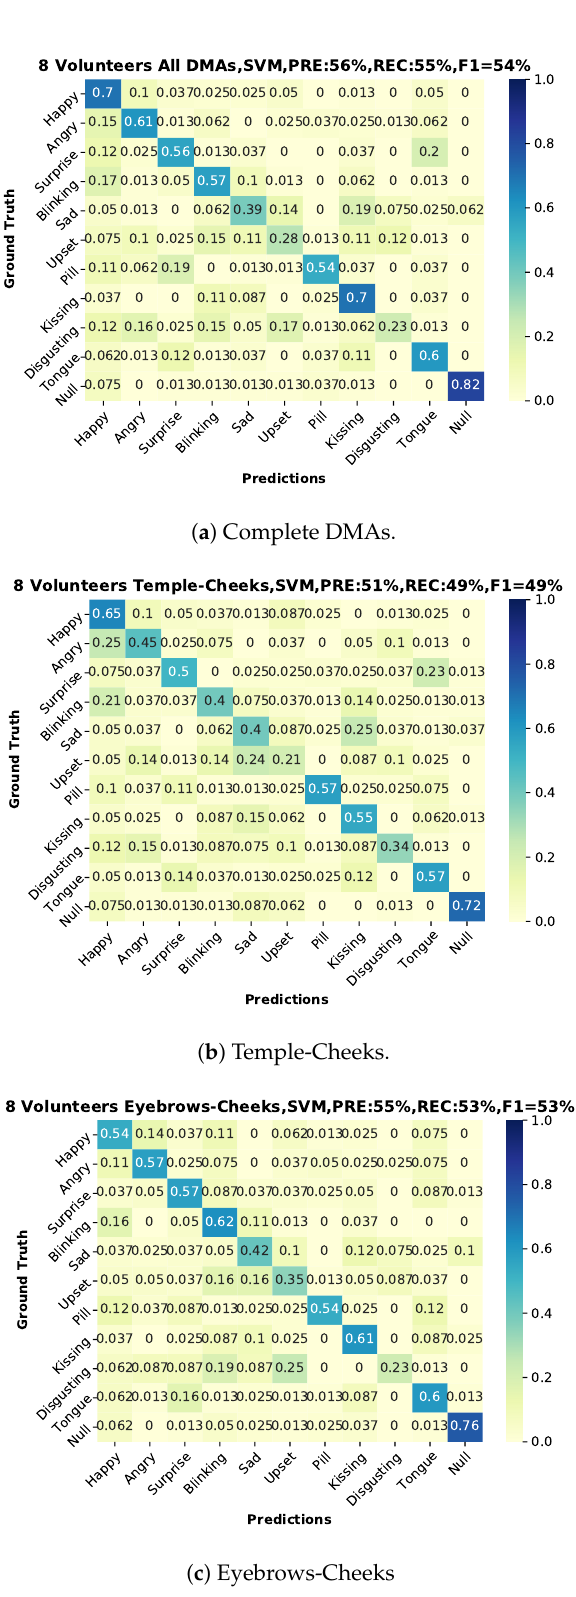
Figure 14. Confusion matrices user-independent, two sessions for training and one for testing with classifier, precision, recall and f1-score. ( a ) All volunteers using 11 combinations of first order DMAs. ( b ) All volunteers using 6 combinations of first order DMAs, only temples-cheeks. ( c ) All volunteers using 6 combinations of first order DMAs, only